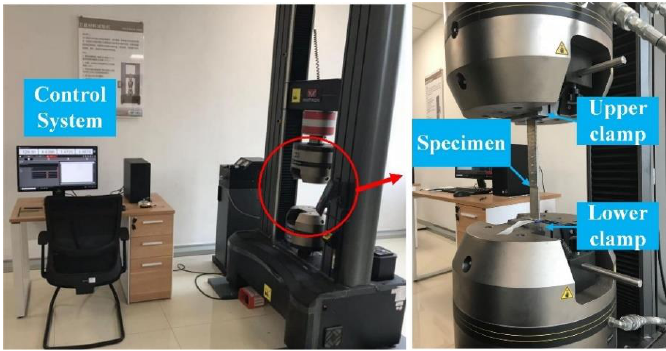
Figure 16. The static tensile tests using INSTRON 5985 universal testing machine.